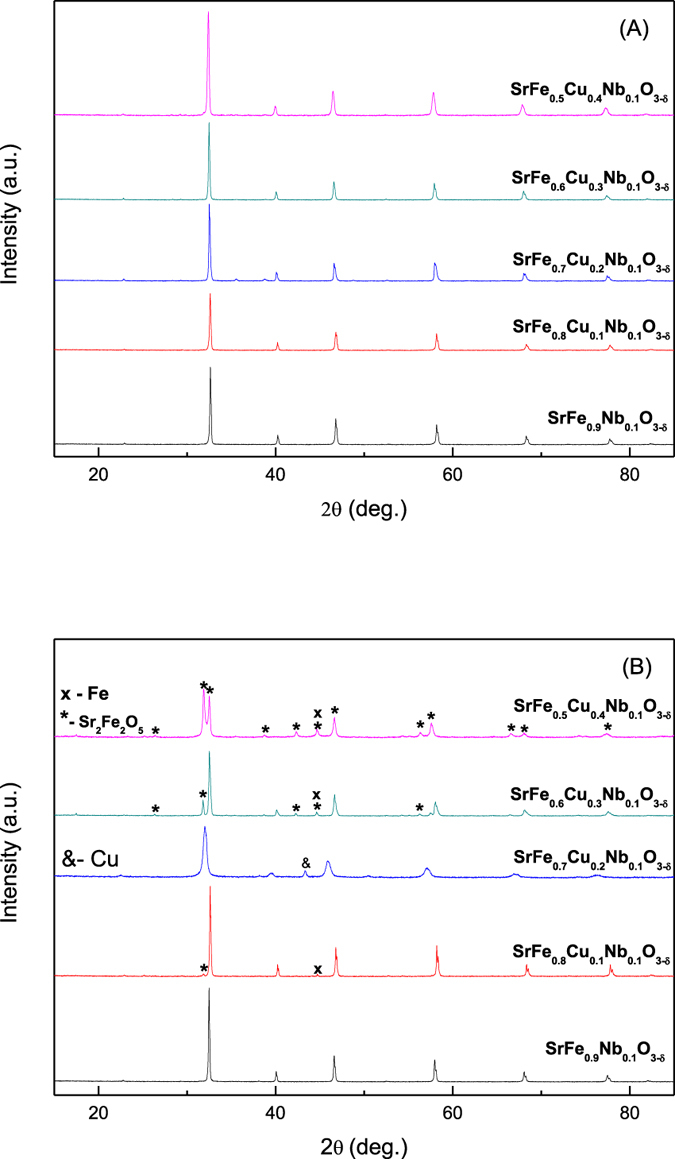
Room temperature X-ray diffraction patterns of SrFe0.9−xCuxNb0.1O3−δ (x = 0–0.4) (x = 0–0.4) after obtained in air (A) and after further reduction in 5%H2/Ar at 700 °C for 10 hours (B).